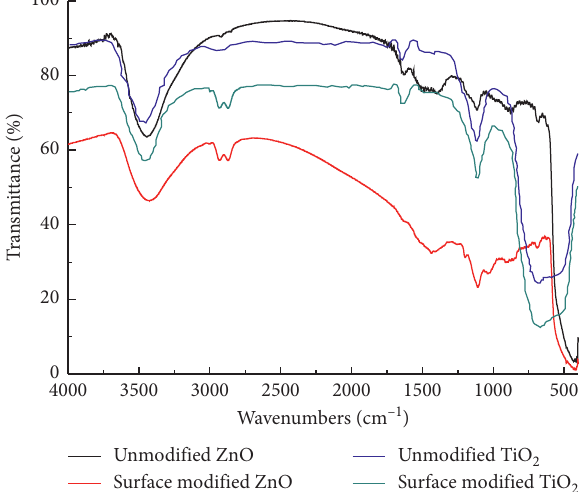
Figure 3: FTIR spectra of nanomaterials before and after surface modification by KH-560.